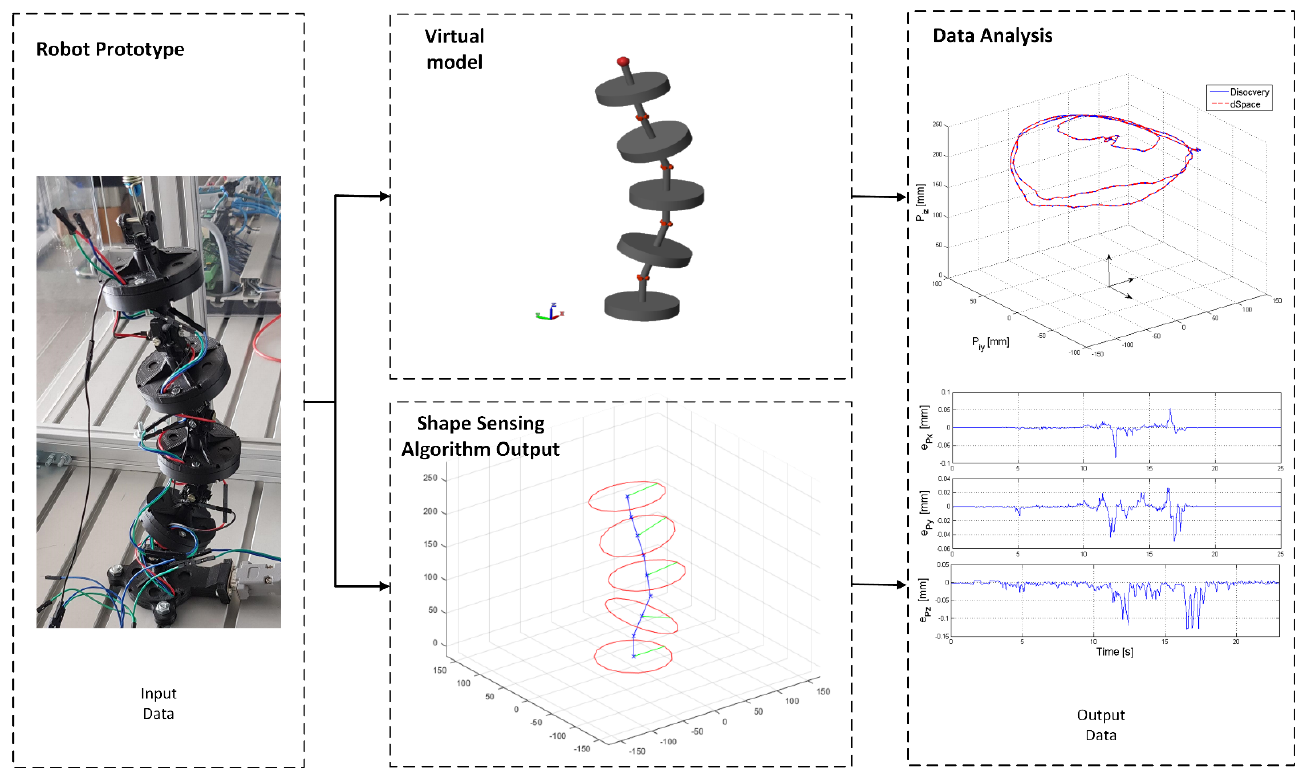
Figure 7. HIL testing method—validation of experimental results.